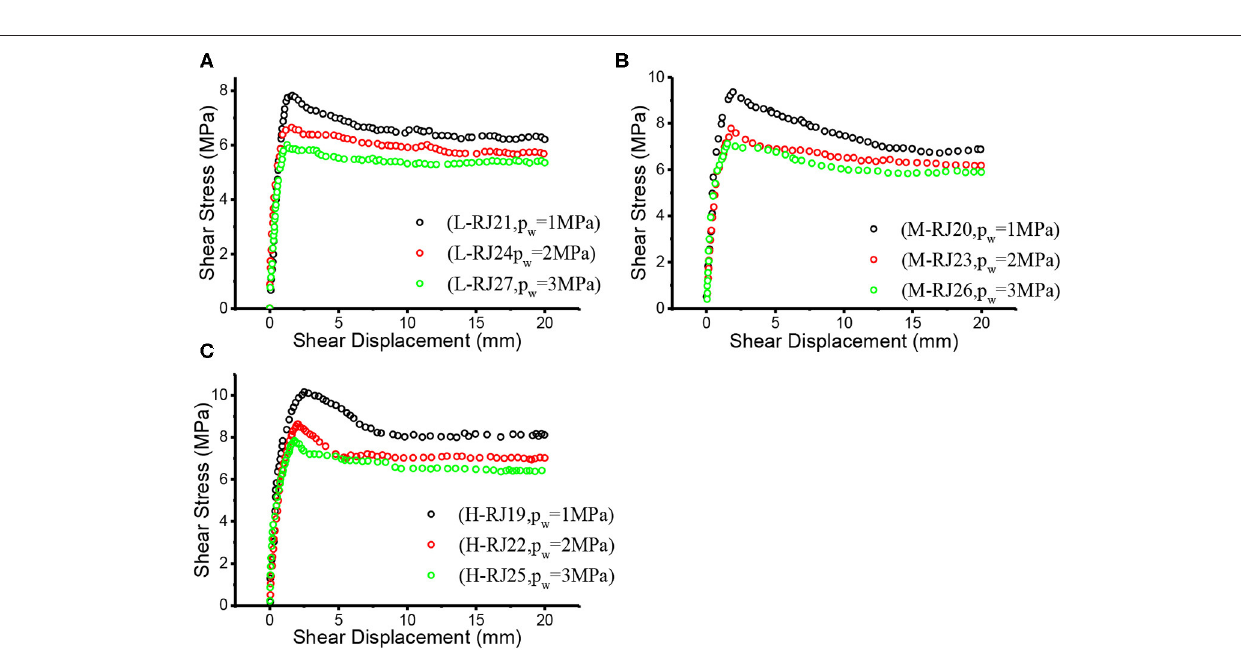
FIGURE 3 | Shear stress-displacement curves of three joint groups under normal stress of 10MPa and three different seepage pressures. (A) L joint (B) M joint (C) H joint.